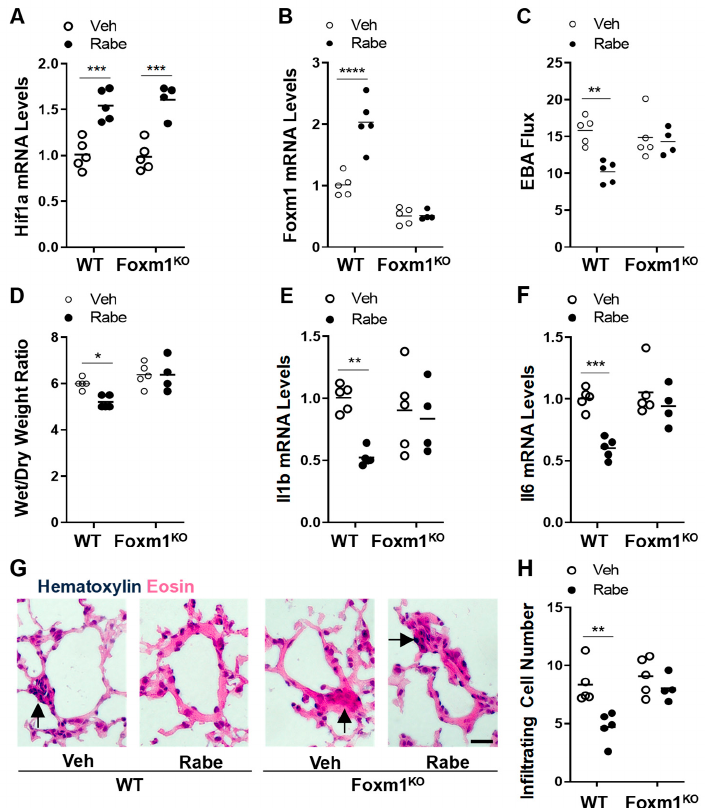
Figure 7. Genetic disruption of FoxM1 abrogates the reparative effects of Rabeprazole following sepsis-induced inflammatory lung injury. ( A ) Quantitative RT-PCR analysis of HIF-1 α and ( B ) FoxM1 expression in mouse lungs. WT or conditional Foxm1/Tie2 Cre (Foxm1 KO ) mice received LPS (2.5 mg/kg, i.p.). At 4 and 20 h post-LPS, mice were treated with PBS vehicle or Rabeprazole (18 mg/kg, oral). Lungs were analyzed at 52 h post-LPS. ( C ) EBA flux assay demonstrating that Rabeprazole-dependent decreases in lung vascular permeability seen in WT mice were absent in Foxm1/Tie2 Cre mice. ( D ) Lung edema measured by lung wet–dry weight ratio was not inhibited in Rabeprazole-treated Foxm1/Tie2 Cre mice in contrast to Rabeprazole-treated WT mice. ( E ) Quantitative RT-PCR analysis of Il1b and ( F ) Il6 demonstrating that Rabeprazole-dependent decreases in lung inflammation seen in WT mice were absent in Foxm1/Tie2Cre mice. ( G ) Representative images of infiltrating peri-vascular cells in H&E-stained lungs from Rabeprazole-treated and Rabeprazole-free WT and Foxm1/Tie2Cre mice at 52 h post-LPS. Arrows indicate infiltrated peri-vascular cells. Scale bar = 50 µ m. ( H ) Quantifications of infiltrated proinflammatory cells per vessel < 150 µ m. * p < 0.05, ** p < 0.01, *** p < 0.001, and **** p < 0.0001. Two-way ANOVA with Sidak’s